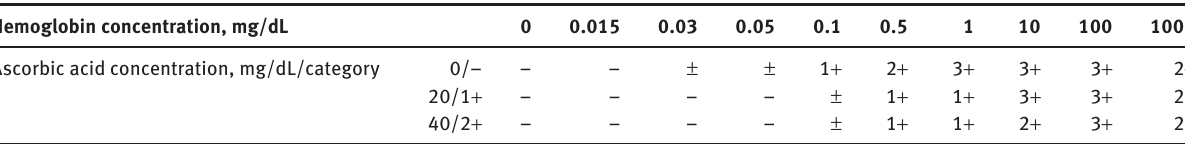
Table 1: Effect of ascorbic acid on the determination of hemoglobin. Hemoglobin concentration, mg/dL